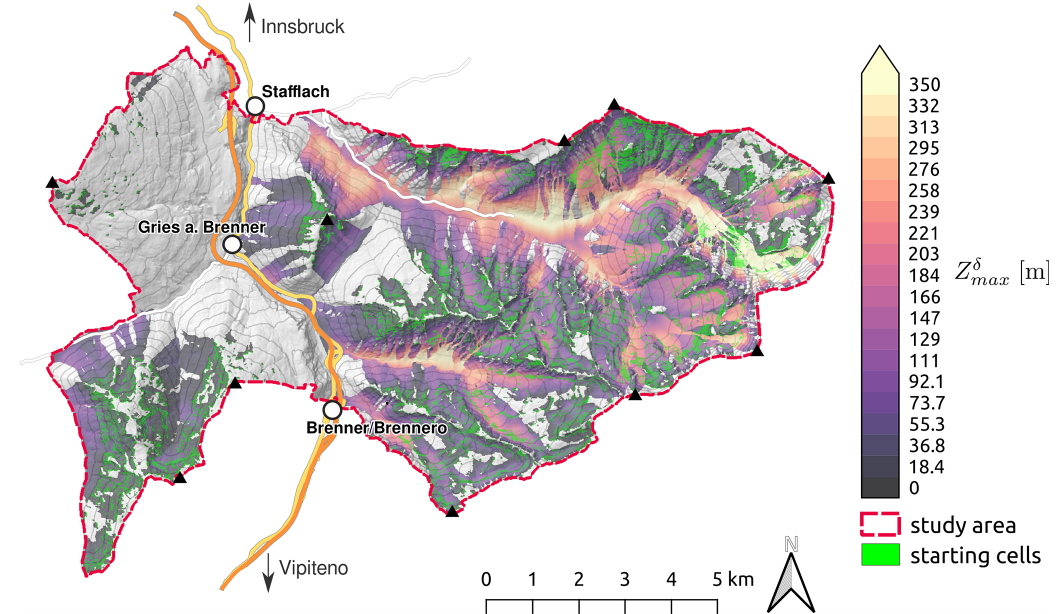
Figure 8. Flow-Py simulation results of snow avalanche runout and intensity ( Z δ max ) in complex terrain on a regional scale. The simulation took 3h and 45min. The map utilizes data from ©OpenStreetMap contributors 2021. Distributed under the Open Data Commons Open Database License (ODbL) v1.0 and Land Tirol (https://www.tirol.gv.at/statistik-budget/tiris/, last access: 1 March 2021) issued under a Creative Commons Attribution 4.0 International (CC BY 4.0)